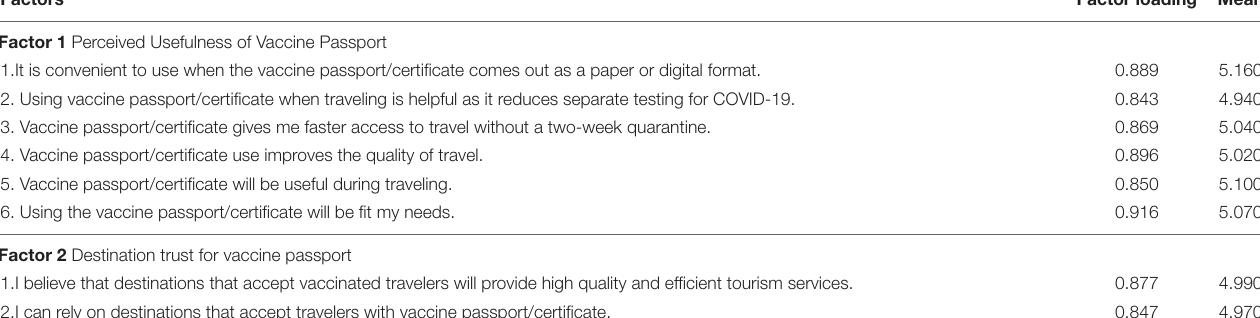
TABLE 3 | CFA results. Factors Factor loading Mean Factor 1 Perceived Usefulness of Vaccine